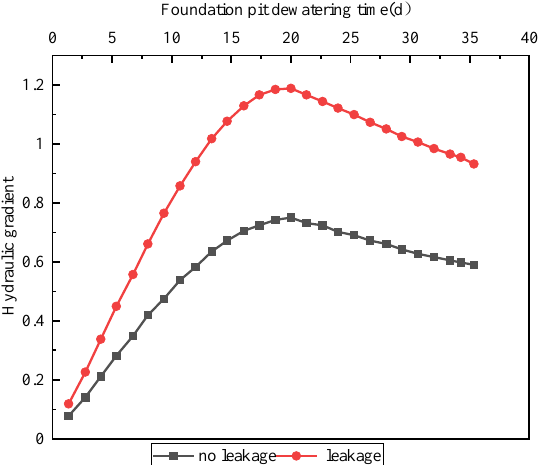
Figure 14. The diagram of the hydraulic gradient with precipitation time of the envelope with and without leakage.